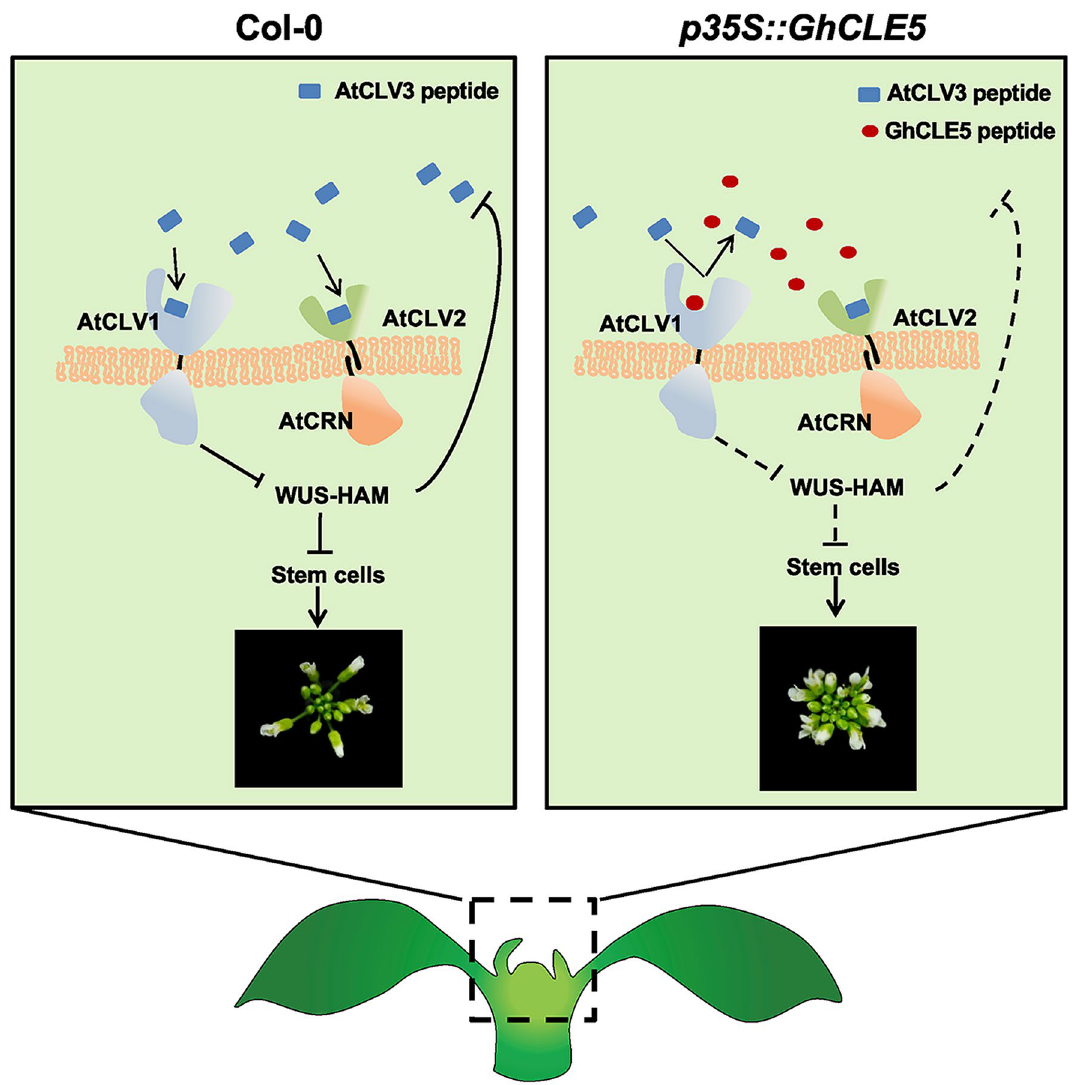
Figure 8. The working model for the ectopic effects of GhCLE5 in Arabidopsis